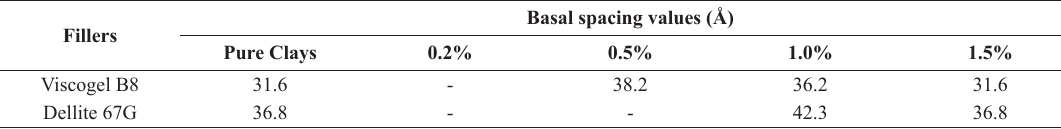
Table 3. Basal spacing values of pure clays and of adhesives containing varying concentrations of the clays Fillers